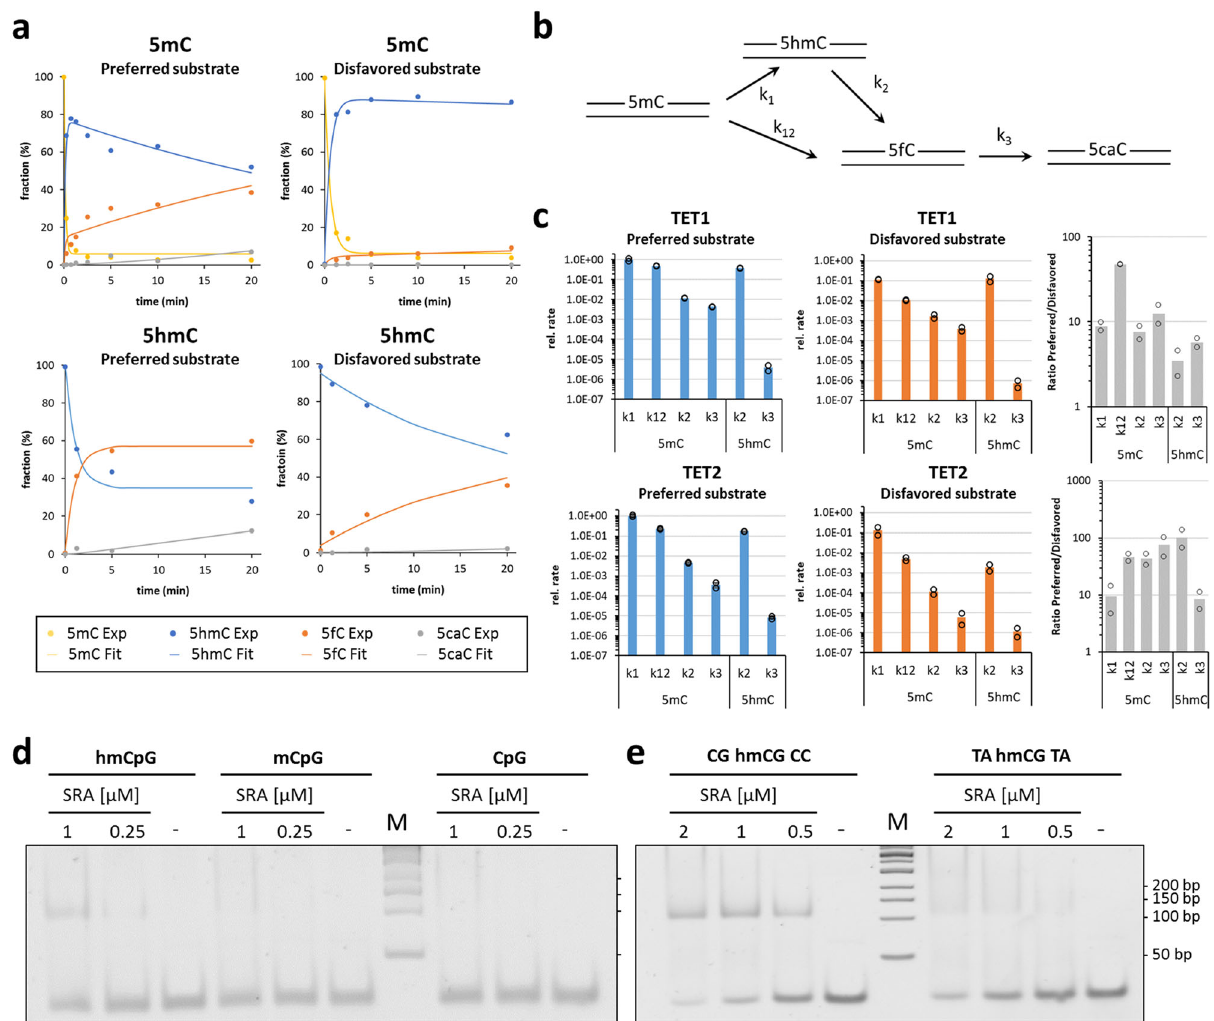
Fig. 3 Biochemical investigation of the fl anking effect of TET1 and TET2 oxidation kinetics and 5hmC binding by UHRF2. a Example of oxidation kinetics of synthetic double-stranded 30mer oligonucleotides containing one hemimethylated (5mC) or hemihydroxymethylated (5hmC) CpG site in different fl anking context by TET2. Product appearance was detected by LC-MS. Enzyme concentrations of TET1 and TET2 were 1.6/2.0 µ M for the favored substrates and 3.2/8 µ M for the disfavored substrates. b Kinetic model used to analyze the data. c Summary of rate constants of oxidation of 5mC and 5hmC substrates by TET1 and TET2. Rates are given as relative values considering that in the reactions with the disfavored substrates more enzyme was used. Shown are averages and data points of two independent repeats. d Gel shift experiments with puri fi ed UHRF2 SRA domain and synthetic double- stranded 30mer oligonucleotides (0.5 µ M) containing one hemihydroxymethylated CpG site (hmCpG), one hemimethylated (mCpG), and one unmodi fi ed CpG site in CGCGCC context. e Gel shift experiments with puri fi ed UHRF2 SRA domain and synthetic double-stranded 30mer oligonucleotides (0.5 µ M) containing one hemihydroxymethylated CpG site in different fl anking